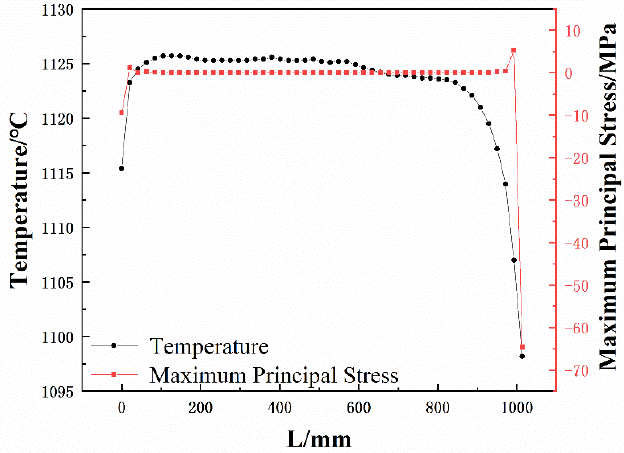
Figure 8. Temperature and maximum principal stress distribution on path 2.